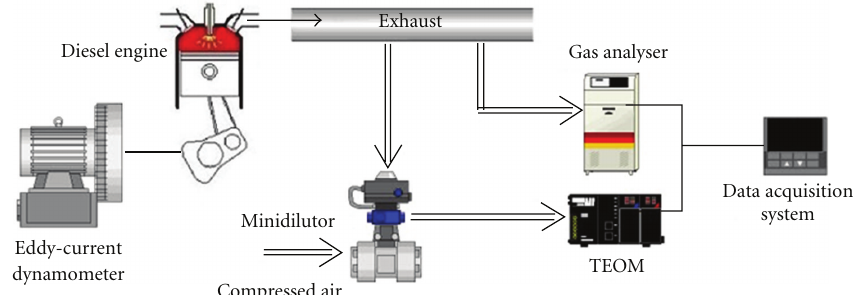
Figure 2: Schematic diagram of experimental setup.